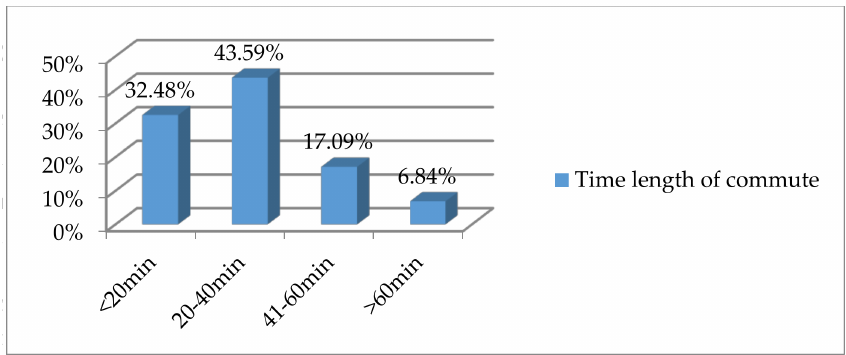
Figure 3. Time length of